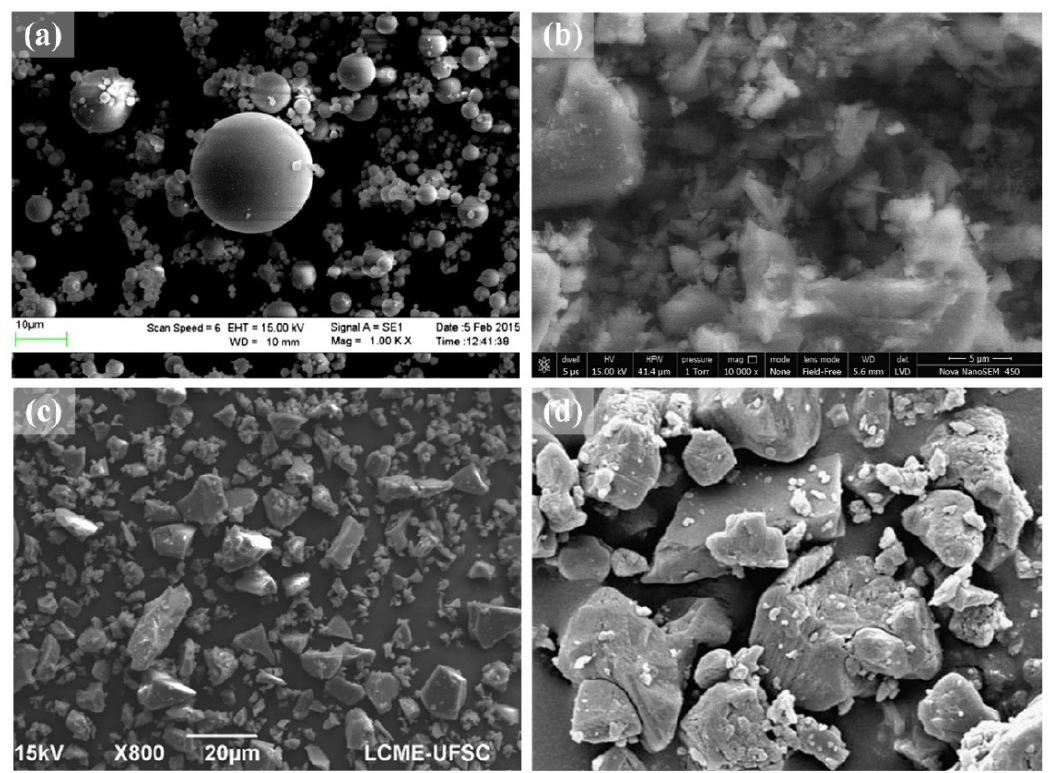
Figure 3. Microscopic image of SCMs: ( a ) FA [23], ( b ) SF [17], ( c ) GBFS [50], ( d ) LP [67].